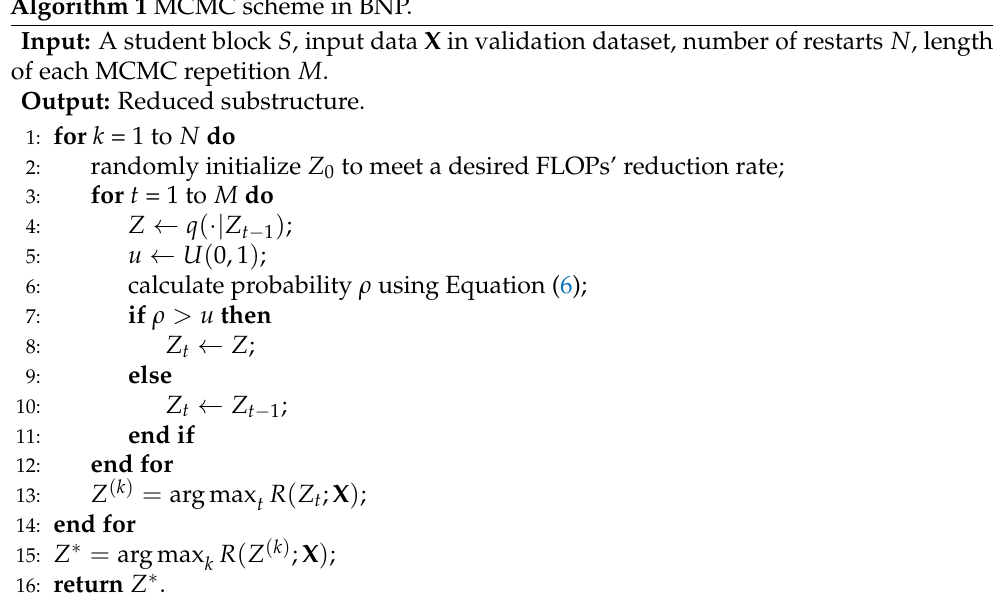
Algorithm 1 MCMC scheme in